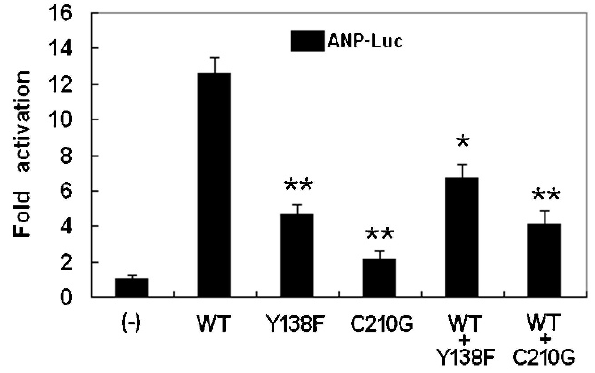
Figure 4 - Functional defects associated with GATA5 mutations. Activation of the ANF -luciferase reporter in HEK-293 cells by wild- type GATA5 (WT), mutant Y138F or mutant C210G, alone or in combination. Expression of the mutant proteins results in significantly reduced transactivation of the ANF promoter. Experiments were performed in triplicate, and means and standard deviations are shown. ** and * indicate p , 0.0005 and p , 0.001, respectively, when compared with